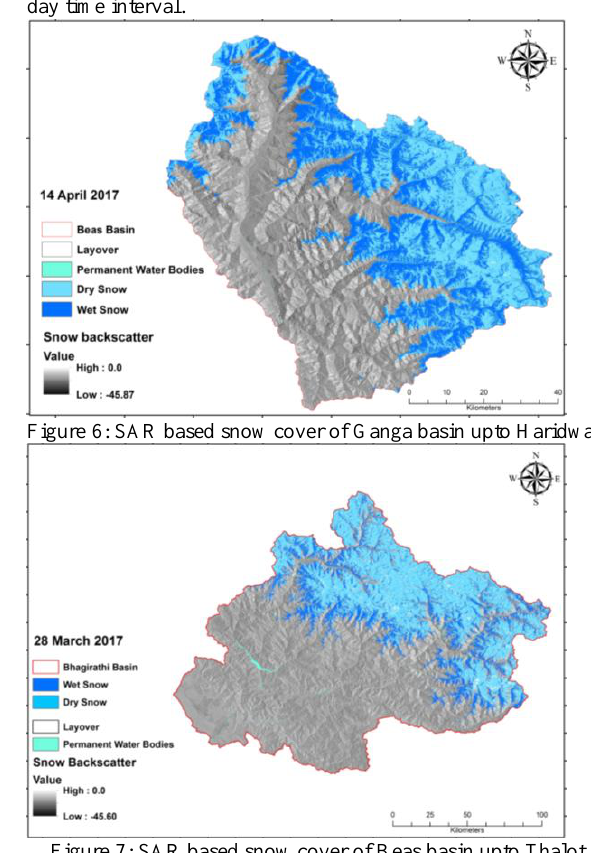
Figure 7: SAR based snow cover of Beas basin upto